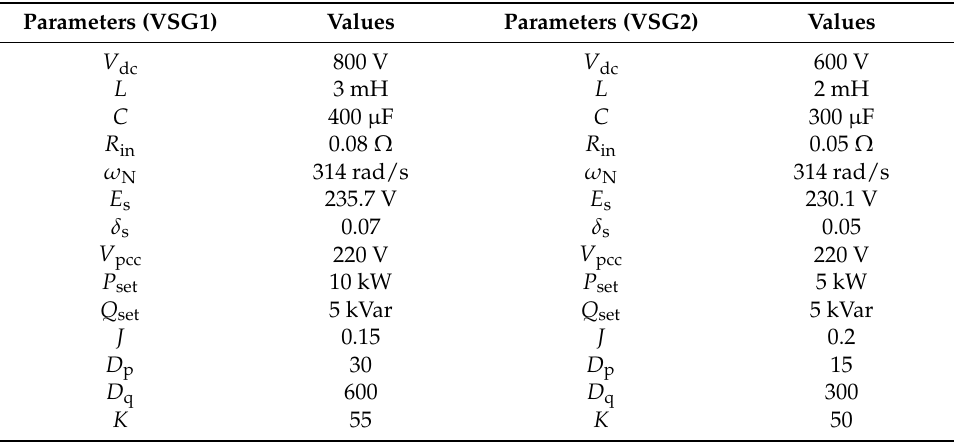
Table 2. Electrical and control parameters of two virtual synchronous generators (VSGs).